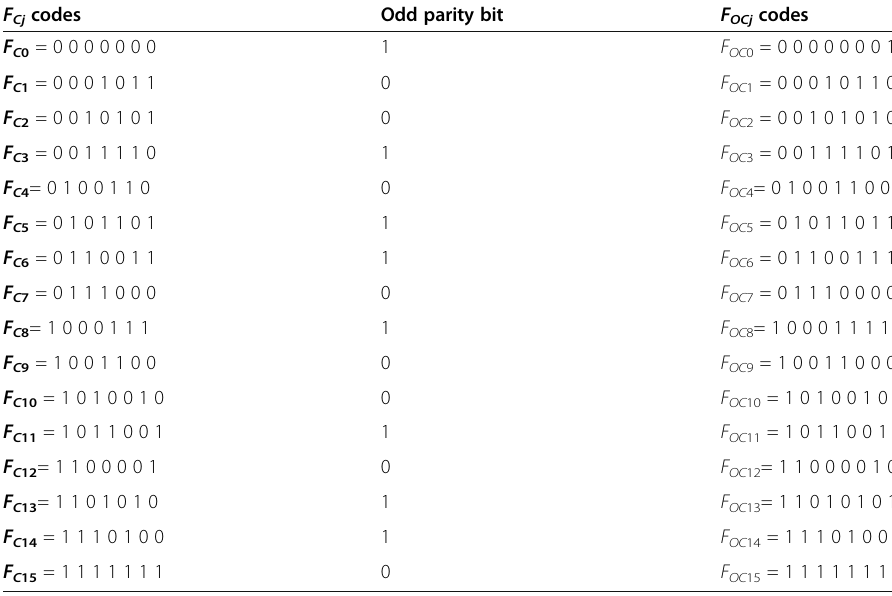
Table 3 Generated codes with odd parity F Cj